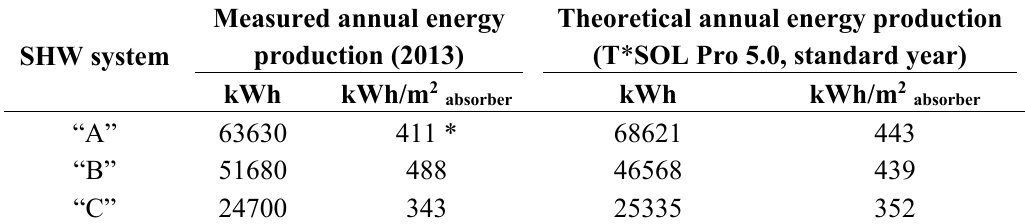
Table 2. Measured and estimated heat energy production of solar collectors systems. SHW